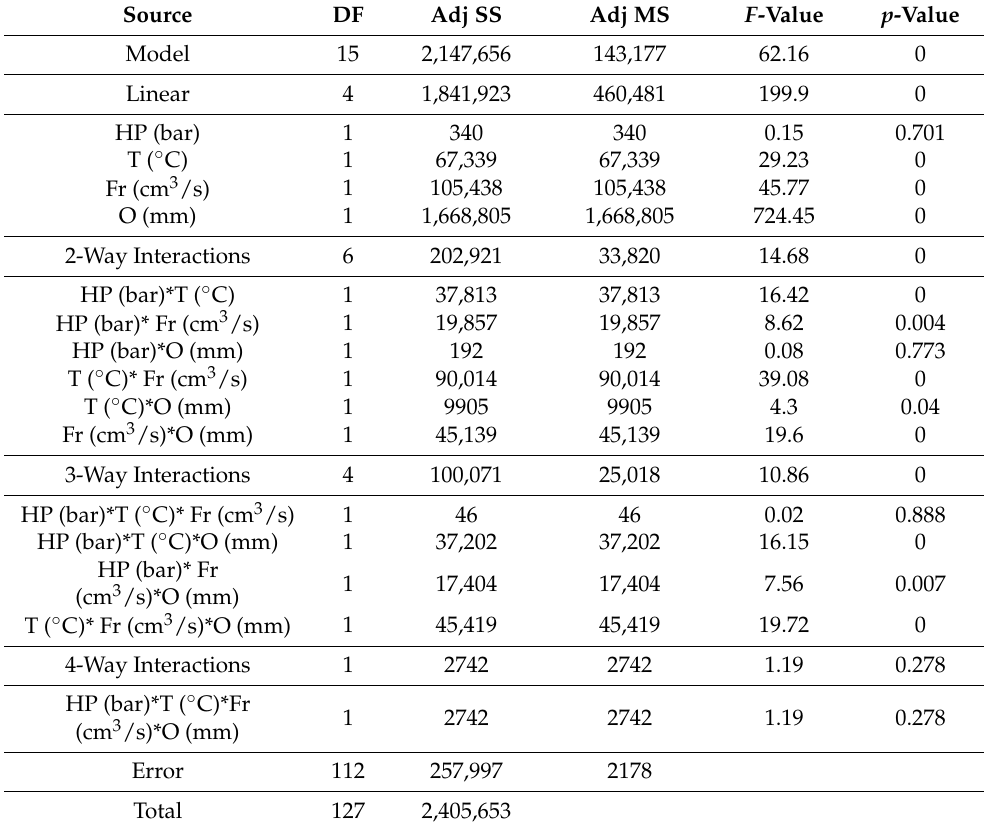
Table 3. Combined ANOVA for the 12- and 16-mm overlaps.